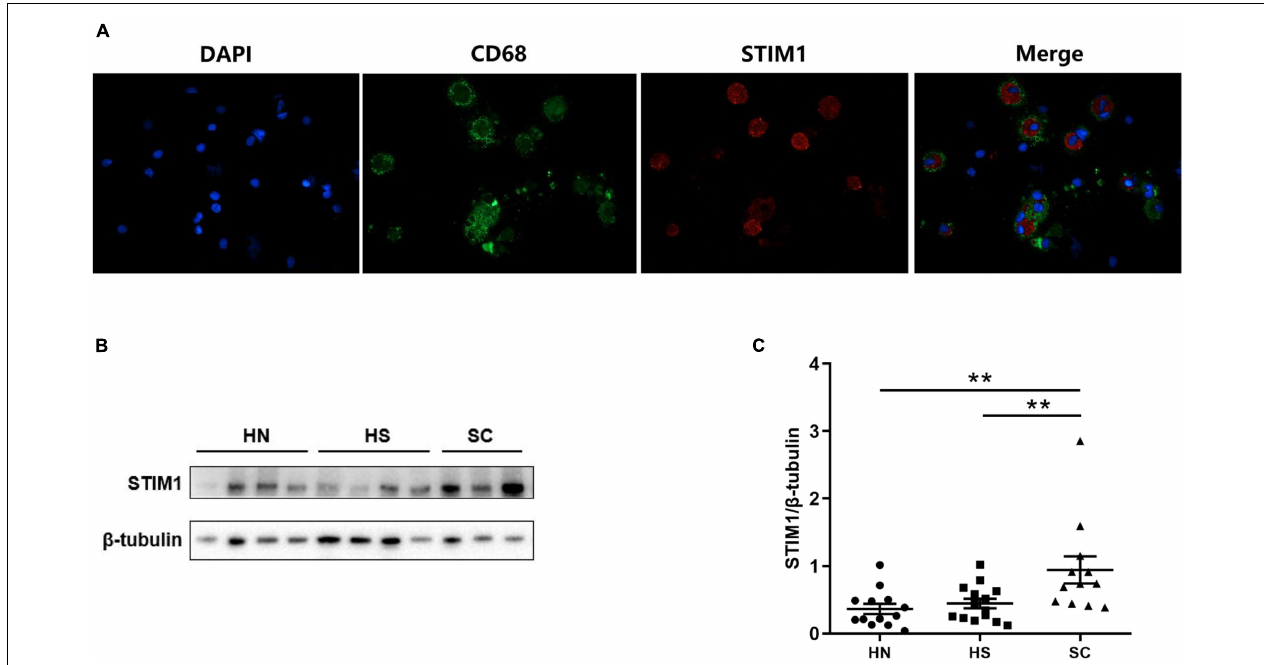
FIGURE 2 | Stromal Interaction Molecule 1 is located in the human alveolar macrophages and up-regulated in macrophages isolated from bronchoalveolar lavage fluid (BALF) of COPD patients. Representative immunofluorescent images against STIM1 in macrophages isolated from BALF are shown (A) . Representative western blot images of STIM1 expression in the macrophages of BALF are shown (B) and quantified using ImageJ (C) . Data are displayed as mean ± SEM, n = 13 for HN, n = 14 for HS, and n = 12 for SC. P -values were calculated using one-way ANOVA followed by Newman–Keuls test. ** P < 0.01 represent significant differences. STIM1, stromal interaction molecule 1; BALF: bronchoalveolar lavage fluid; HN, healthy non-smoker; HS, healthy smoker; and SC, smoker with COPD.